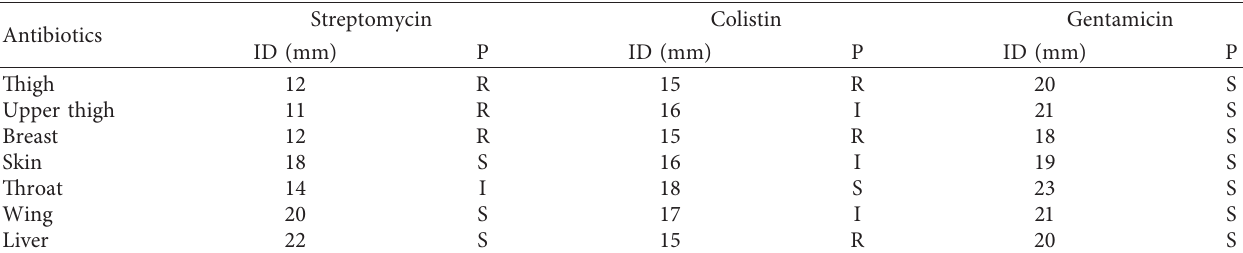
Table 4: Antibiotics sensitivity of Escherichia coli strains in different turkey organs.